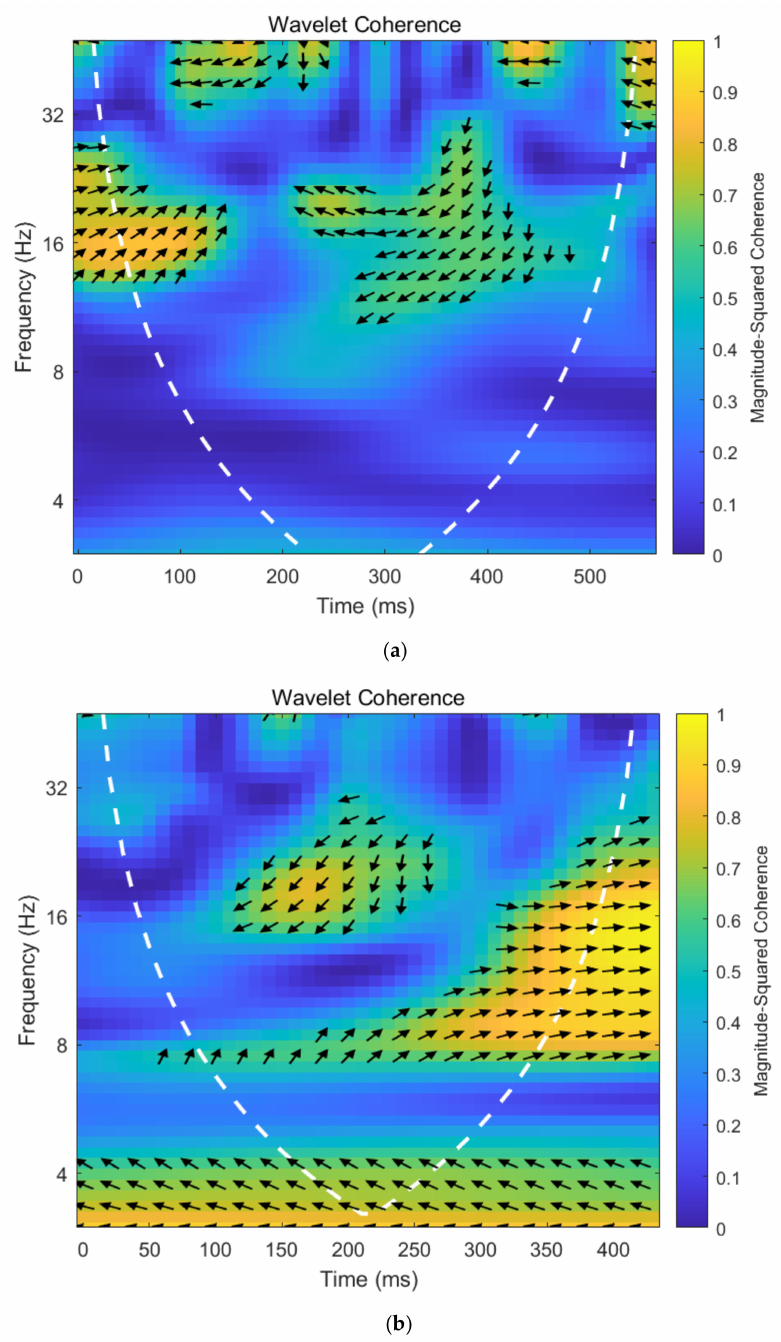
Figure 8. The wavelet coherency map between oil-specific demand shocks and investor sentiment under different trends of crude oil price. ( a ) exhibits the wavelet coherency map of oil-specific demand shocks and investor sentiment under rising trend in crude oil prices, while ( b ) presents the wavelet coherency map of oil-specific demand shocks and investor sentiment under down trend in crude oil prices. The color of a region from blue to yellow implies the coherence correlation between oil-specific demand shocks and investor sentiment become greater. The arrows show the correlation and lead–lag relationship between oil-specific demand shocks and investor